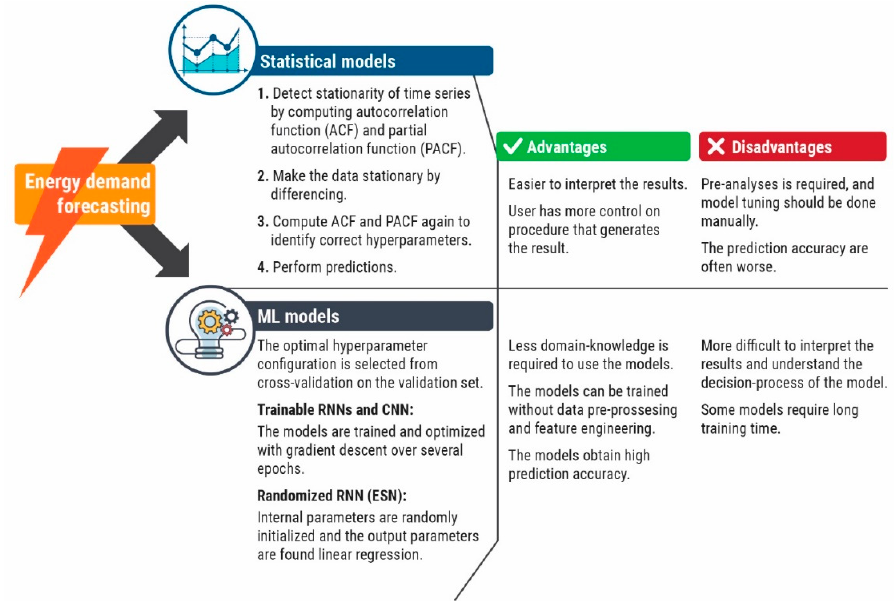
Figure 1. Overview of methodology for making predictions with statistical-and machine-learning models. The advantages and disadvantages of each approach are given.